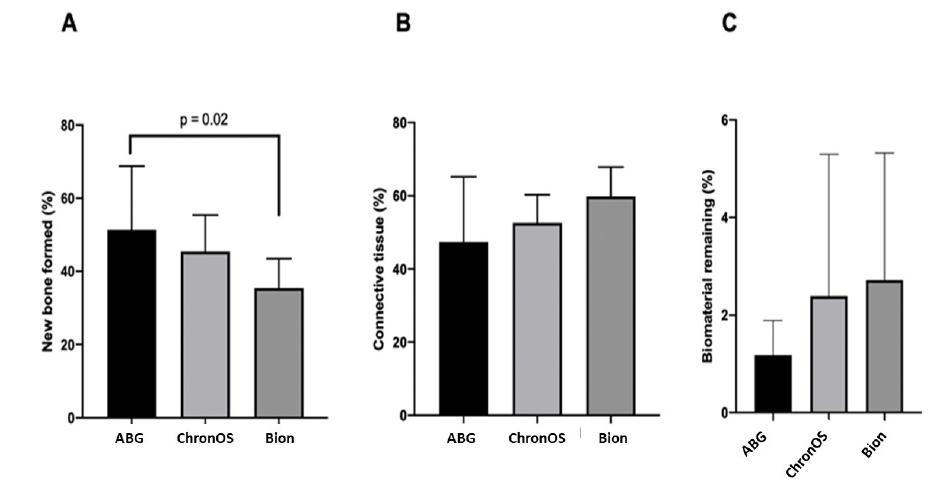
Figure 3. Graphic showing the histomorphometric outcomes for new bone formation ( A ), connective tissue ( B ), and biomaterial remaining ( C ) after 6 months in the human maxillary sinus augmented with the three bone substitutes studied.